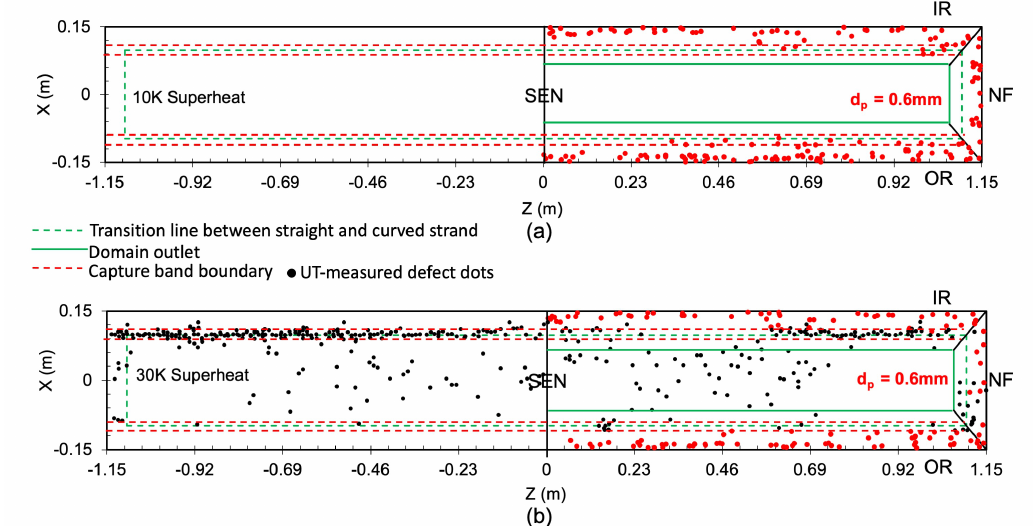
Figure 16. Capture locations of 0.6 mm bubbles comparing simulations and UT measurements—end view—( a ) 10 K superheat and ( b ) 30 K